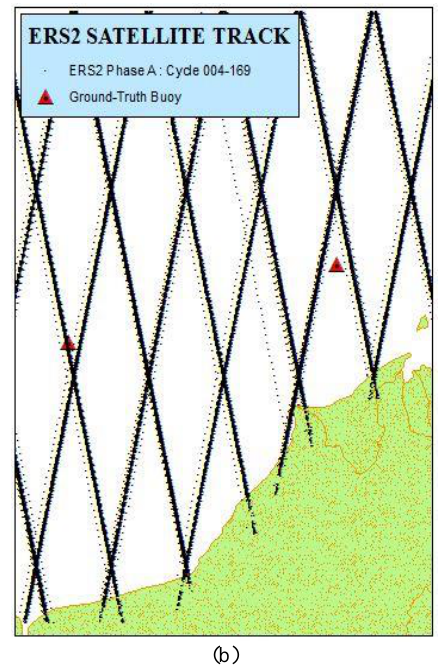
Figure 7. Satellite track over the ground truth buoy, (a) satellite track from ENVISAT-1 and (b) is satellite track from ERS-2